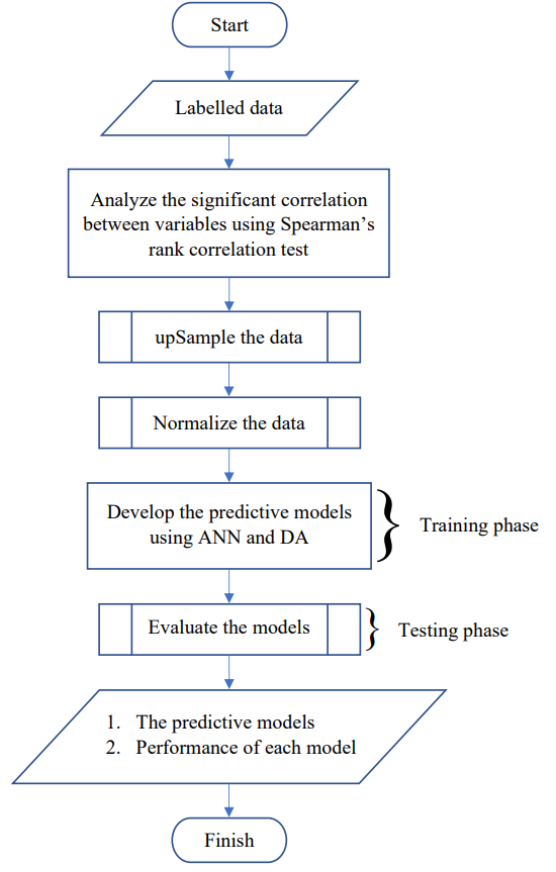
Figure 1. Experiment workflow.